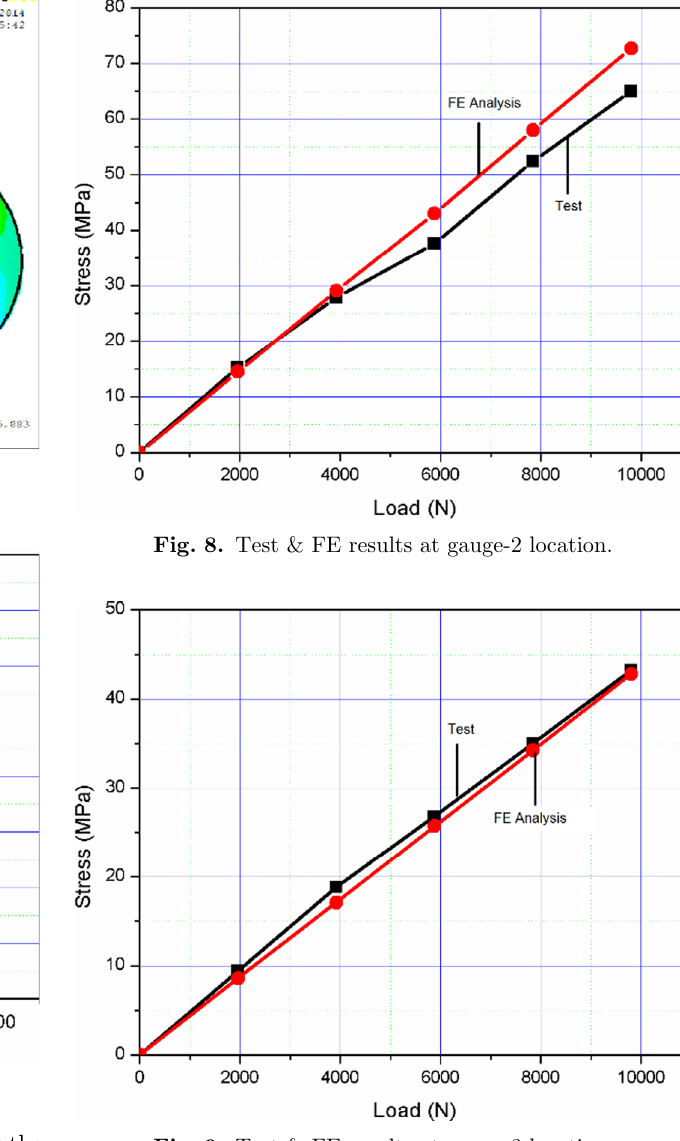
Fig. 9. Test & FE results at gauge-3